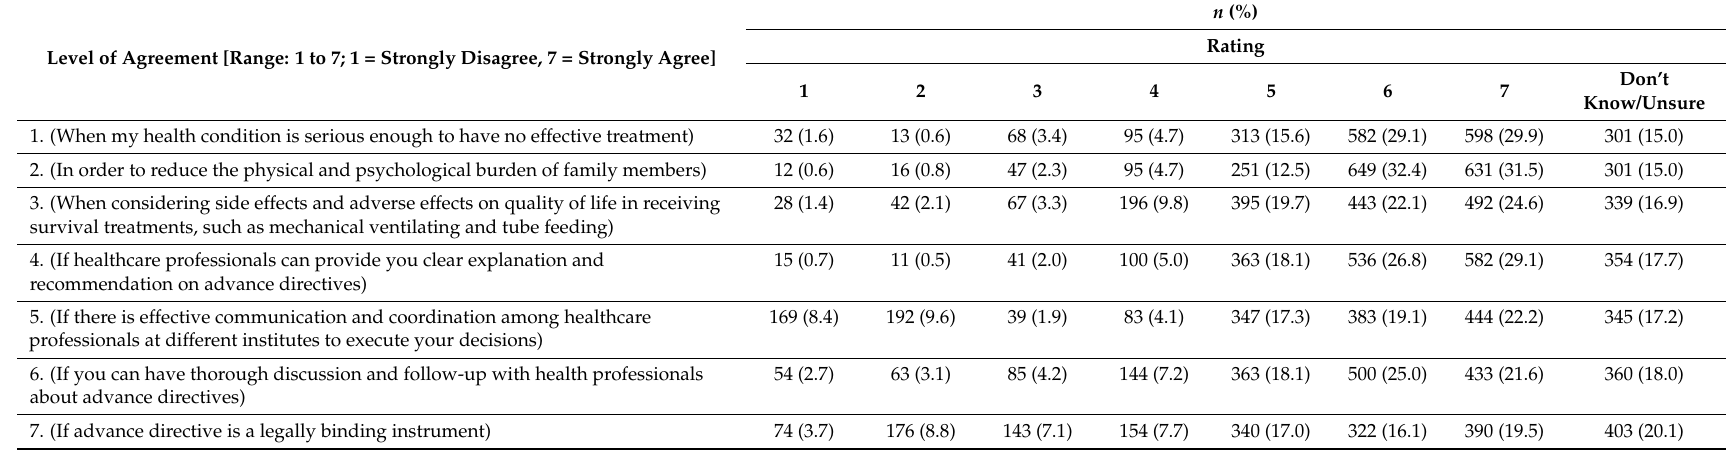
Table 4. Level of agreement in making advance directives in various scenarios ( n = 2002).